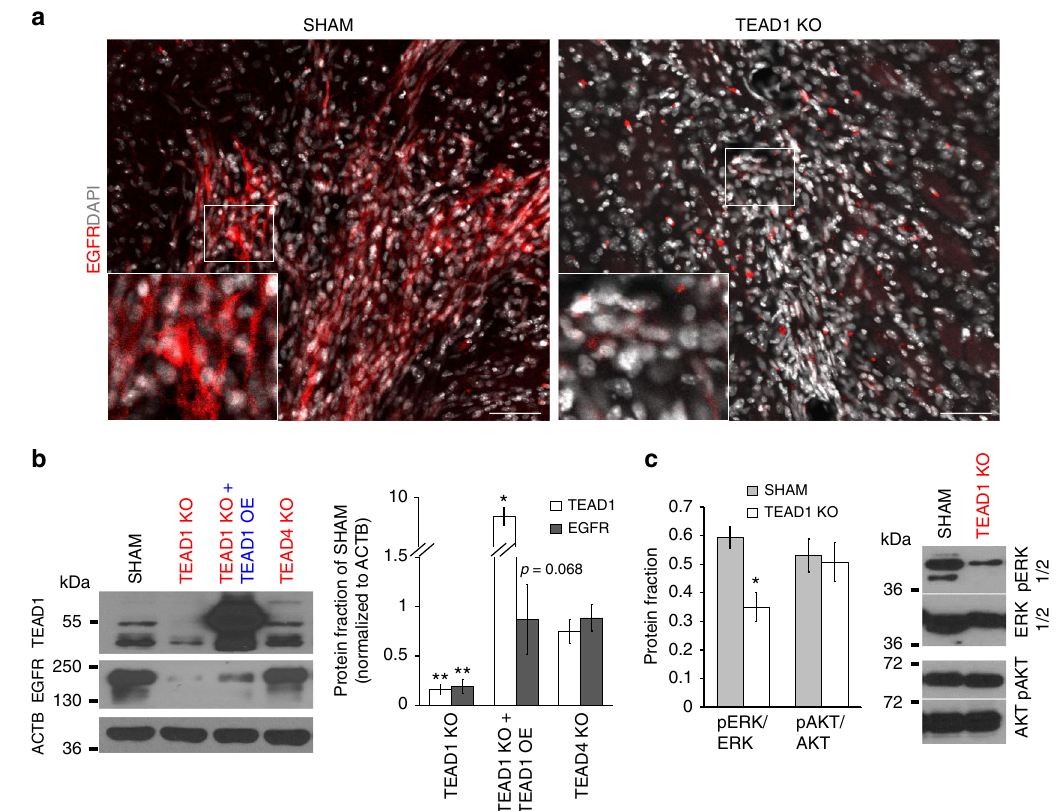
Fig. 6 TEAD1 regulates expression of EGFR. a Immuno fl uorescence image depicts observed expression of EGFR in sham and TEAD1-knockout G-13063 xenografts 3.5 months post transplantation. Scale bar = 50 μ M. b Western immunoblot depicts marked downregulation of EGFR in vitro after knockout of TEAD1, but not TEAD4, in G-13063 cells, which is partially restored after TEAD1 overexpression for 48 h. On right is a bar graph quanti fi cation of immunoblots from three independent experiments ( n = 3; TEAD1KO vs. TEAD4KO: ** p = 0.004 and ** p = 0.003 for TEAD1 and EGFR, respectively; TEAD1KO + TEAD1OE vs. TEAD1KO: * p = 0.01 for TEAD1; p = 0.068 for EGFR in one tail t -test analysis. Bars represent mean ± SEM). c Western immunoblot depicts downregulation of pERK/ERK but not pAKT/AKT in TEAD1KO cells, compared to sham ( n = 3 cell lines; pERK/ERK: * p = 0.029; bars represent mean ± SEM). On right are shown representative immunoblot images from one cell